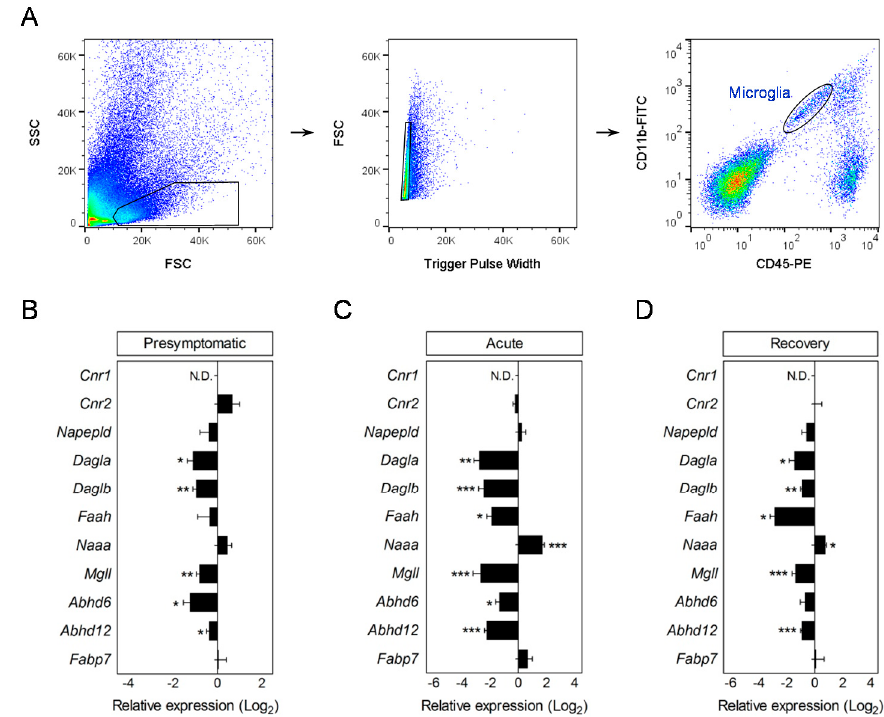
Figure 3. Altered expression of microglial endocannabinoid system genes during EAE. ( A ) Flow cytometry gating strategy for the analysis of microglial cells from EAE mice. Microglia were sorted as CD11b + cells with low CD45 expression. ( B – D ) RT-qPCR analysis of endocannabinoid signaling genes in microglia purified at presymptomatic ( B ), acute ( C ), and recovery ( D ) phases of EAE. Fold changes in relative expression compared to naïve microglia were determined as log 2 ( n = 5–6 mice group).